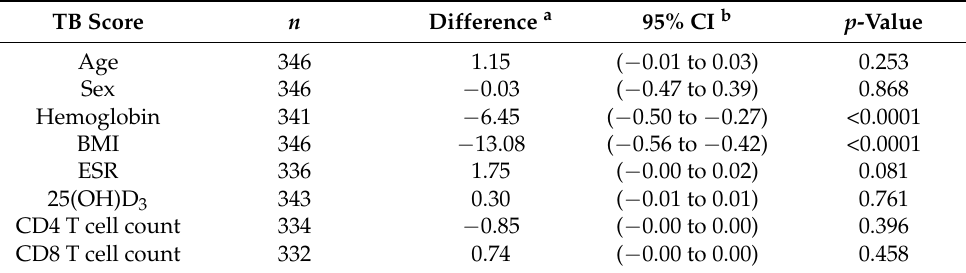
Figure 3. Baseline variables in non-anemic compared to anemic TB patients including ( A ) blood Hb, ( B ) clinical TB score, ( C ) BMI, ( D ) MUAC, ( E ) ESR, ( F ) CD4 T cell counts, ( G ) CD8 T cell counts, and ( H ) IFN- γ . Data (mean or mean ± SD) are presented in bar graphs or scatter plots and were analyzed using an unpaired t -test, p < 0.05 *, p < 0.005 **, p < 0.0005 ***, p < 0.0001 ****. Table 2. Independent effect of key variables on clinical TB